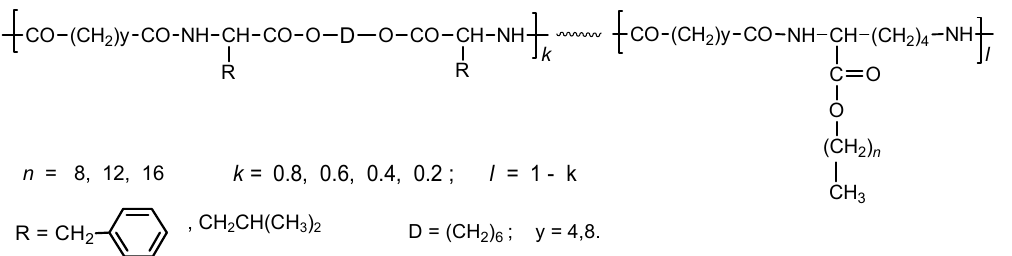
Figure 33. Brush-like copolymeric AABBP composed of L -lysine n -alkyl